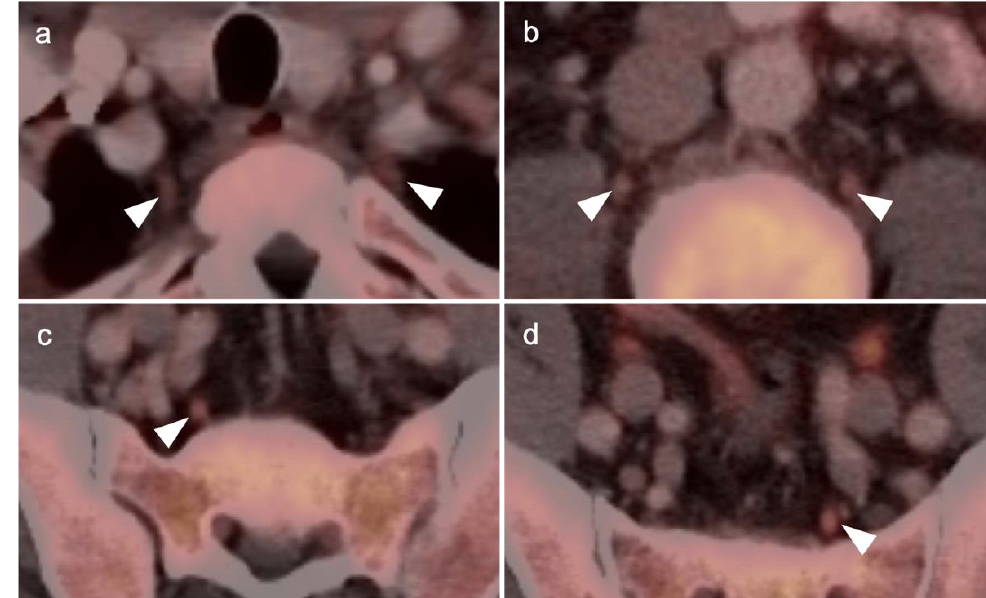
Figure 35. [ 18 F]-Fluciclovine PET-CT showing mild uptake in the sympathetic ganglia (white arrow- heads). ( a ) Stellate ganglia; ( b ) lumbar ganglia; ( c , d ) sacral ganglia. PSMA PET-CT shows a similar pattern of uptake in the sympathetic ganglia. Celiac ganglia are similarly seen (not shown here). Both of the FDA-approved and commercially available PSMA ligands may show increased uptake of radiotracer in a wide range of other solid tumors, both benign and ma- lignant, including high grade glioma, breast cancer, meningioma, hepatocellular carcinoma, renal cell carcinoma, lung cancer, GIST tumor, urothelial carcinoma, hepatic hemangiomas, testicular/embryonal and others [118]. [ 18 F]-Fluciclovine PET-CT has also been shown to have increased uptake in cutaneous and head and neck squamous cell carcinoma, meningiomas and melanoma, both lobular and ductal breast cancer, lymphoma, multiple myeloma, colon cancer, carcinoid tumors and lung cancer, nerve sheath tumors and thymoma [119]. Most of the time, the magnitude of uptake on PSMA or [ 18 F]-fluciclovine PET-CT in non-prostatic sites of tumor is less than would be expected for prostate cancer. However, for example, with PSMA ligand uptake in GIST tumors (Figure 36), and meningiomas, uptake can be intense. It is fair to say that with either fluciclovine or PMSA PET-CT, any atypical or unexpected site of uptake, or uptake in a lesion that is larger than would be expected for the degree of PSA elevation, should be regarded in light of